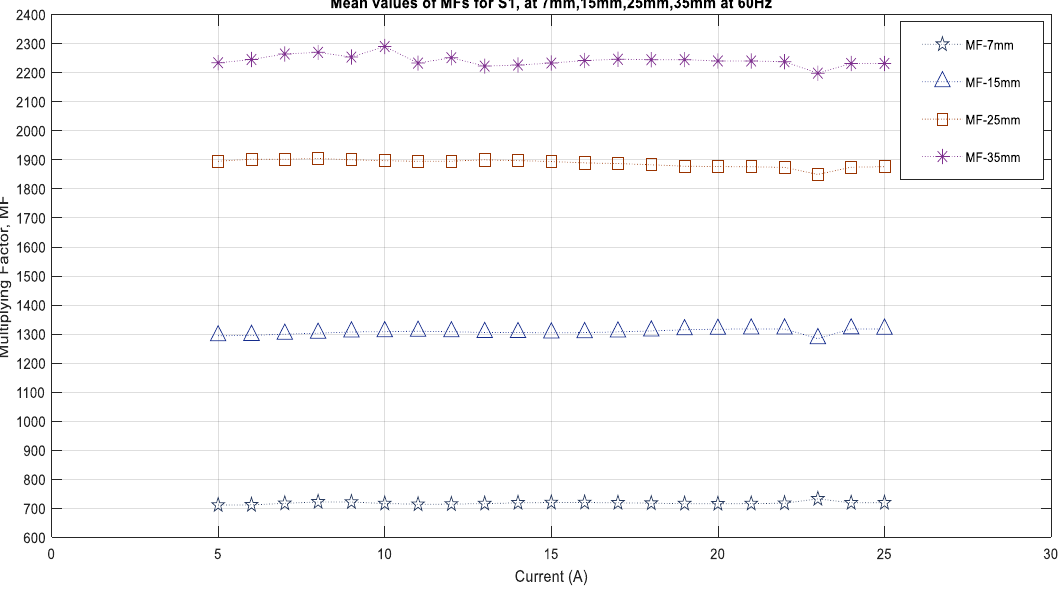
Figure 8. Multiplying factors for the sensor S1 for various distances.